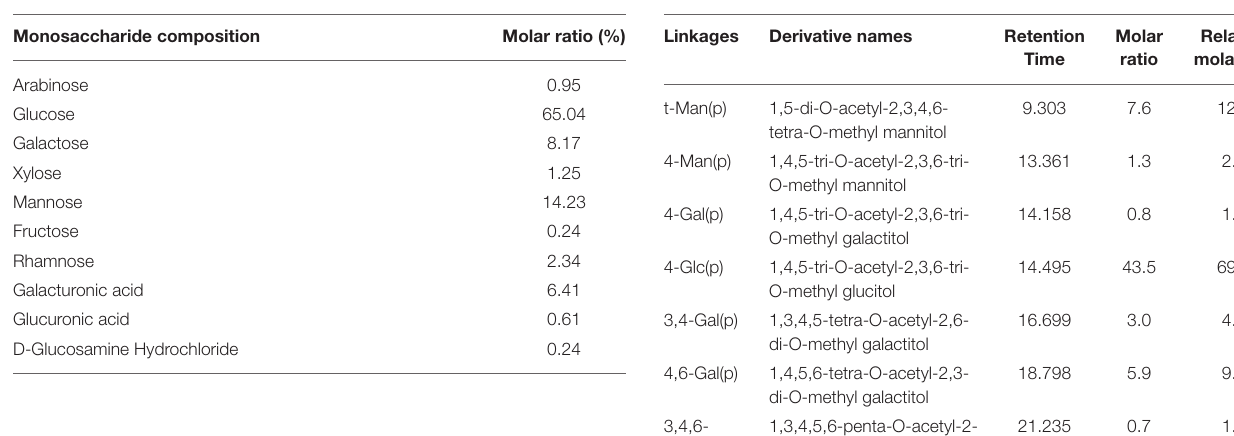
TABLE 3 | Monosaccharide composition of DHPs-1. TABLE 4 | Methylation analysis for